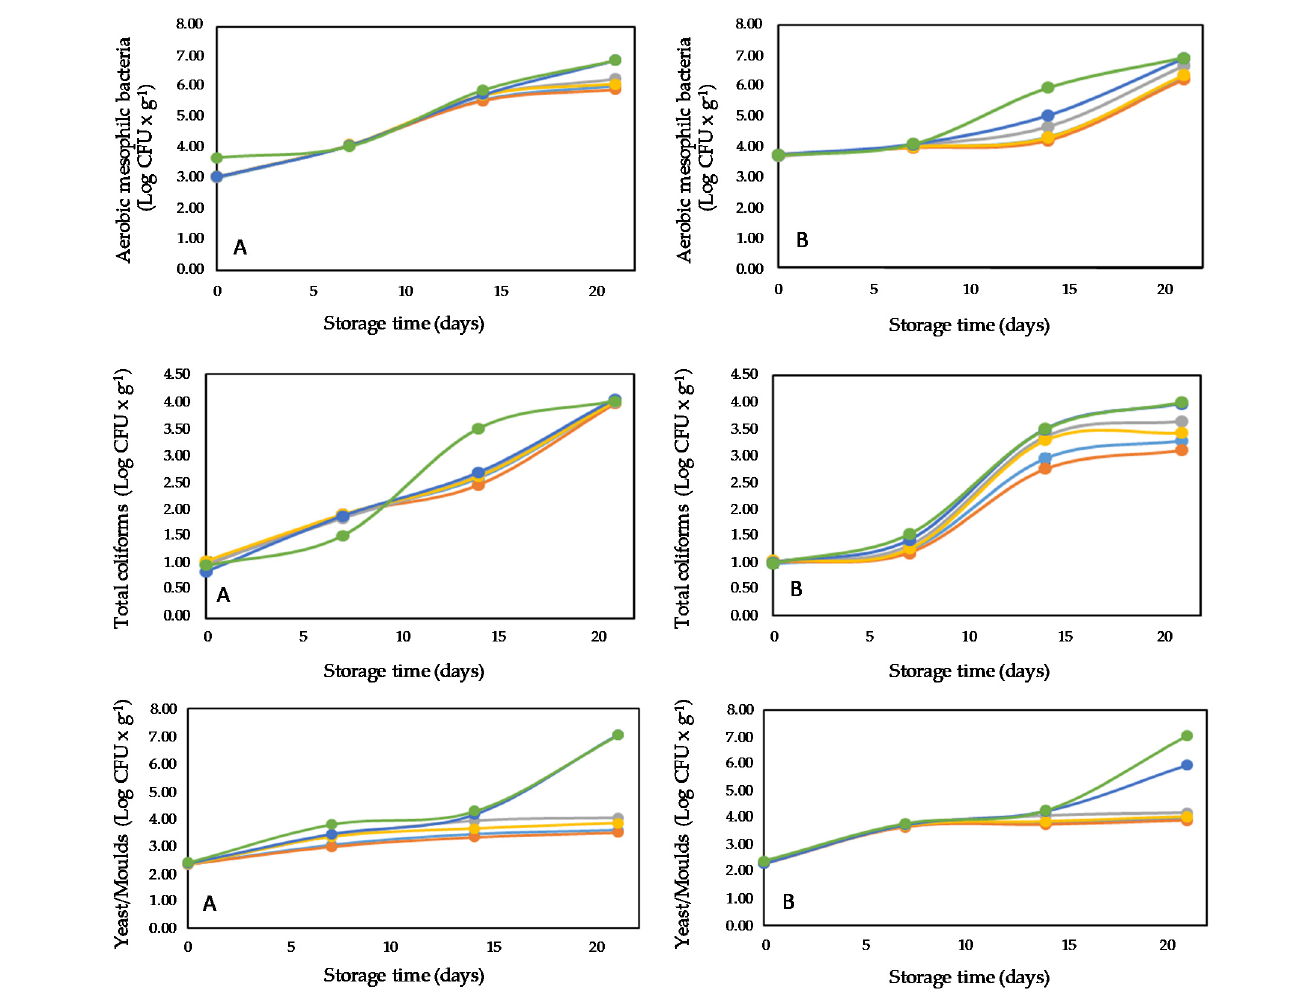
Figure 5. Effect of the type of packaging and storage time (0, 7, 14, 21 days) at 4 °C on the grow of aerobic mesophilic bacteria, totals coliforms, and yeast and molds in blackberries ( A ) and raspberries ( B ).